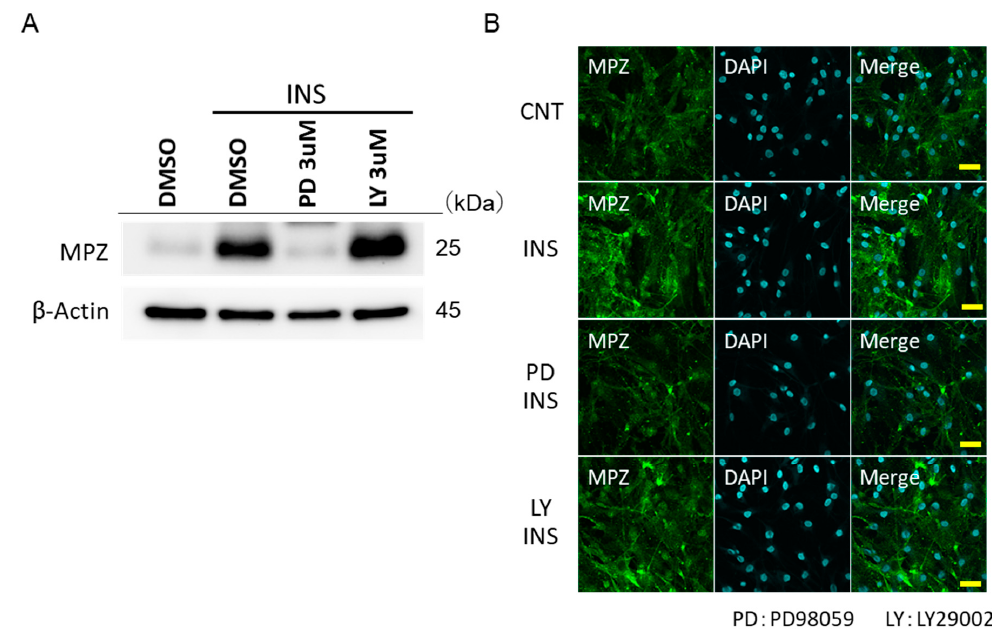
Figure 4. Data on insulin-stimulated myelin protein zero (MPZ) expression through various inhibitors. ( A ) Western blot data showing the expression of MPZ through insulin stimulation, and the effect of LY294002 and PD98059 on MPZ. The results of one of three experiments with similar results are shown. * p < 0.05 versus insulin (DMSO control). ( B ) Immunofluorescence-stained image of MPZ. Green indicates MPZ and blue indicates DAPI (Bar = 100 µ m).